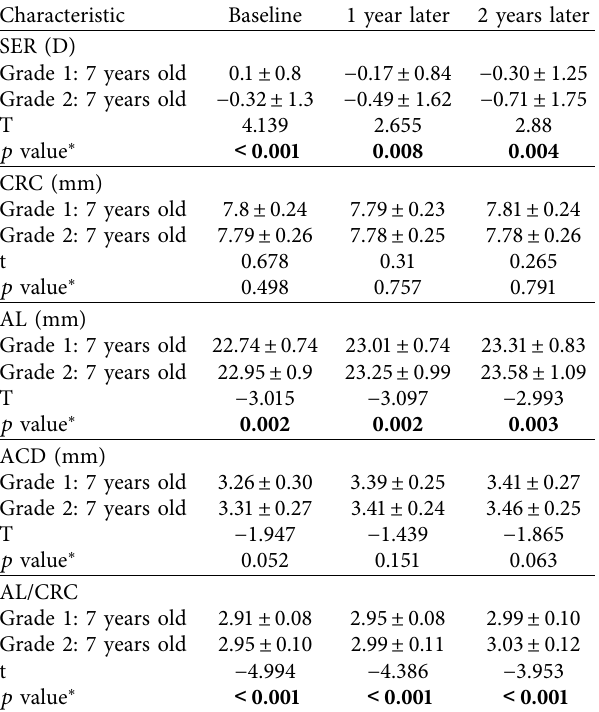
Table 1: Comparison of 2.5-year follow-up characteristics between 320 grade-one and 218 grade-two students who were 7 years old at